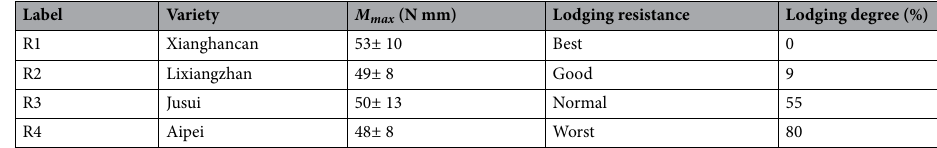
Table 1. Maximum bending moment M max of fresh culms; Lodging resistance and lodging degree of rice plants. The symbol ± in table refers to the distribution range of